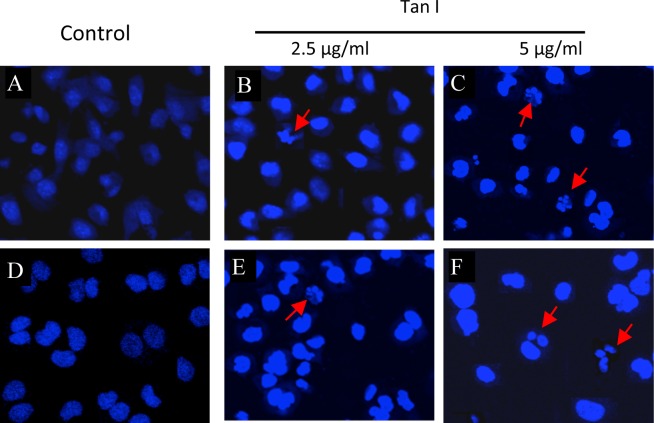
Morphological changes in the nucleolus of breast cancer cells following treatment with Tan I for 48 h under a fluorescence microscope (magnification, ×400) following DNA-binding fluorescent dye staining. (A–C) MCF-7 cells and (D–F) MDA-MB-453. Cells undergoing apoptosis and nuclear fragmentation are indicated by arrows. Tan I, tanshinone I.